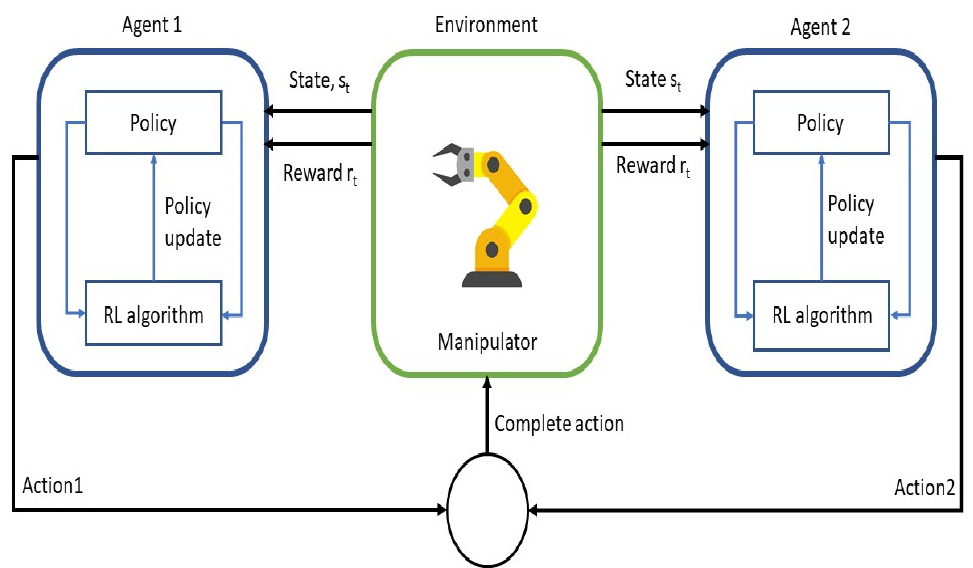
Figure 1. Main conceptual scheme of the proposed approach using a multi-agent and decentralized reinforcement learning